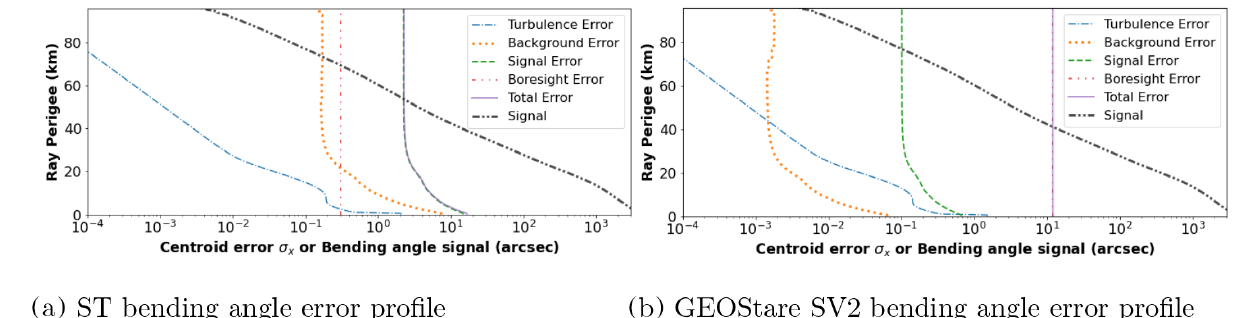
Figure 6. Bending angle error analysis for each satellite. The thick, dash–dot-dotted black line shows the expected bending angle. The blue dash-dotted, orange dotted, green dashed, and thin red dash–dot-dotted lines show the uncertainty in centroid position due to atmospheric turbulence, background signal, photon signal and centroiding, and satellite pointing, respectively. The total uncertainty in the centroid position is shown with the purple solid line.